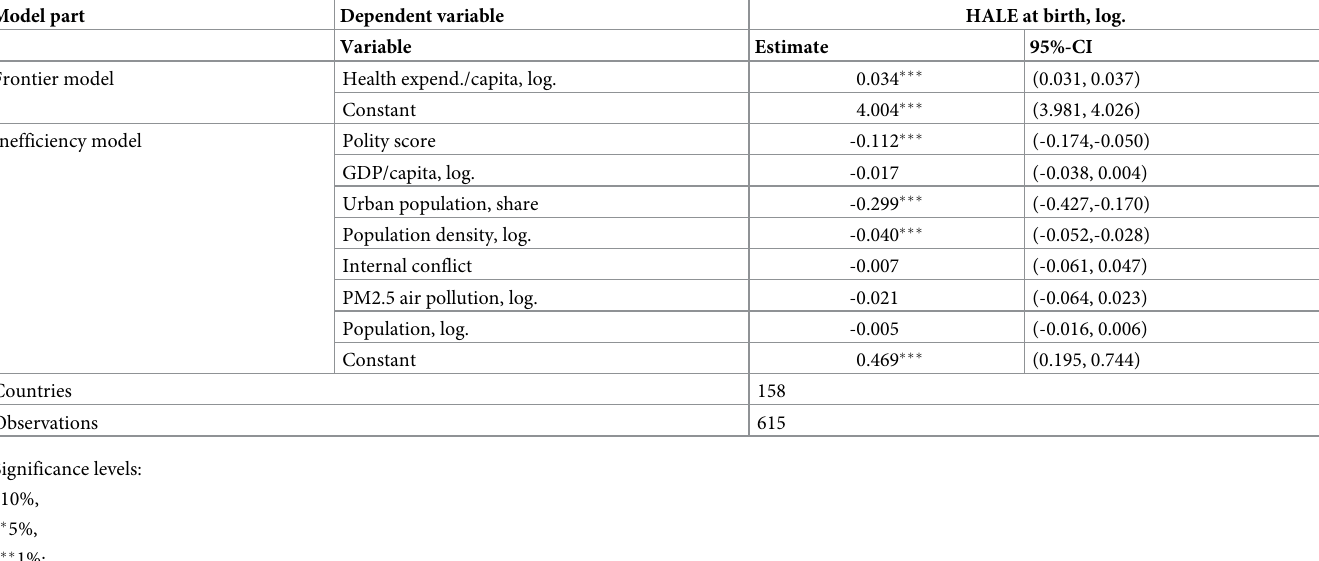
Table 1. Baseline SFA